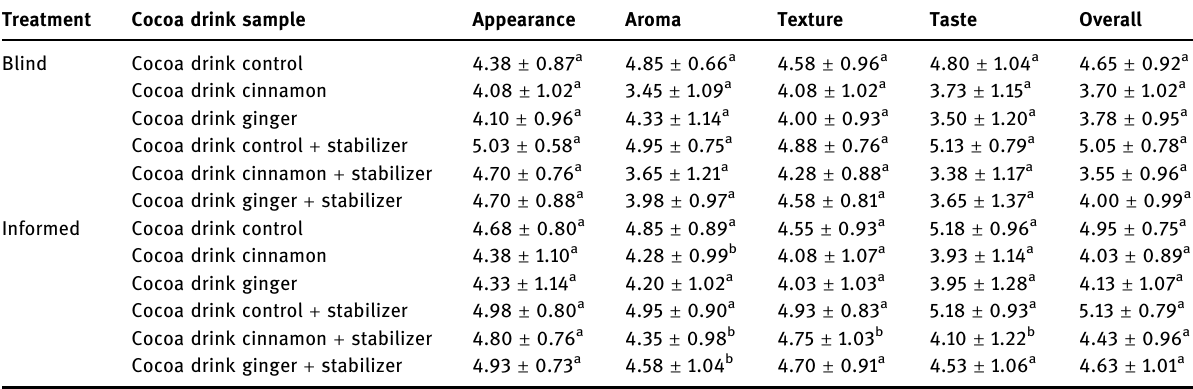
Table 4: The e ff ect of product information on hedonic response of cocoa drinks formulated with ginger and cinnamon Treatment